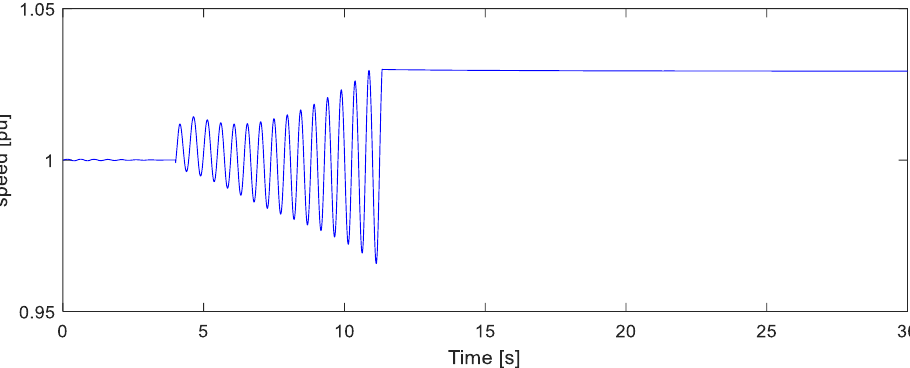
Figure 18. Short-circuit frequency response of the hydro generation unit for the best case of the reference scenario.